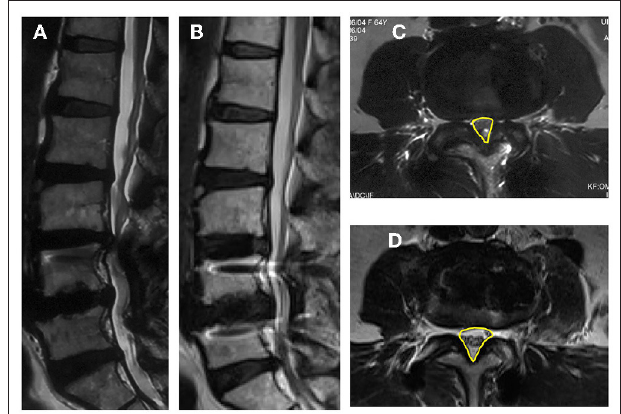
FIGURE 1 | Images obtained in a 62-year-old woman who had an L4–L5 posterior instrumented fusion 6 years earlier. She experienced new back and leg pain and intermittent claudication due to adjacent-segment degeneration and stenosis for 3 months. (A) Pre-operative sagittal MRI; (B) Sagittal MRI at last follow-up post-operative; (C) Pre-operative axial MRI through the L3–4 and CSA (the yellow contour line illustrates); (D) Post-operative axial MRI through the L3–4 and CSA (the yellow contour line